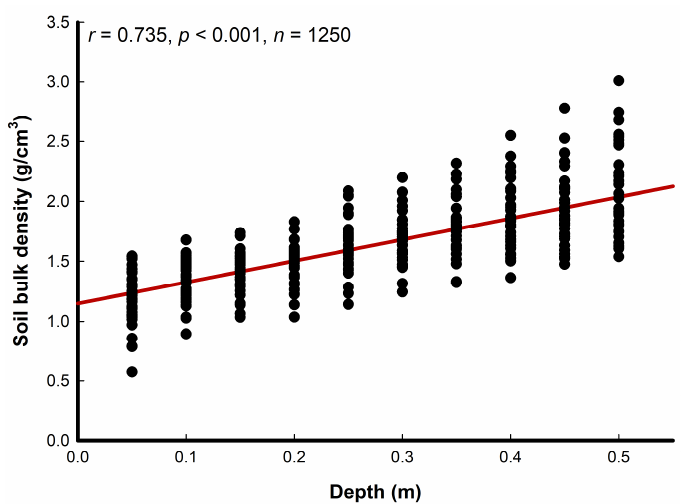
Figure 1. Relationship between soil bulk density (g/cm 3 ) and soil depth in ten sites of sabkhas with different vegetation covers along the southern Red Sea coast of Saudi Arabia.